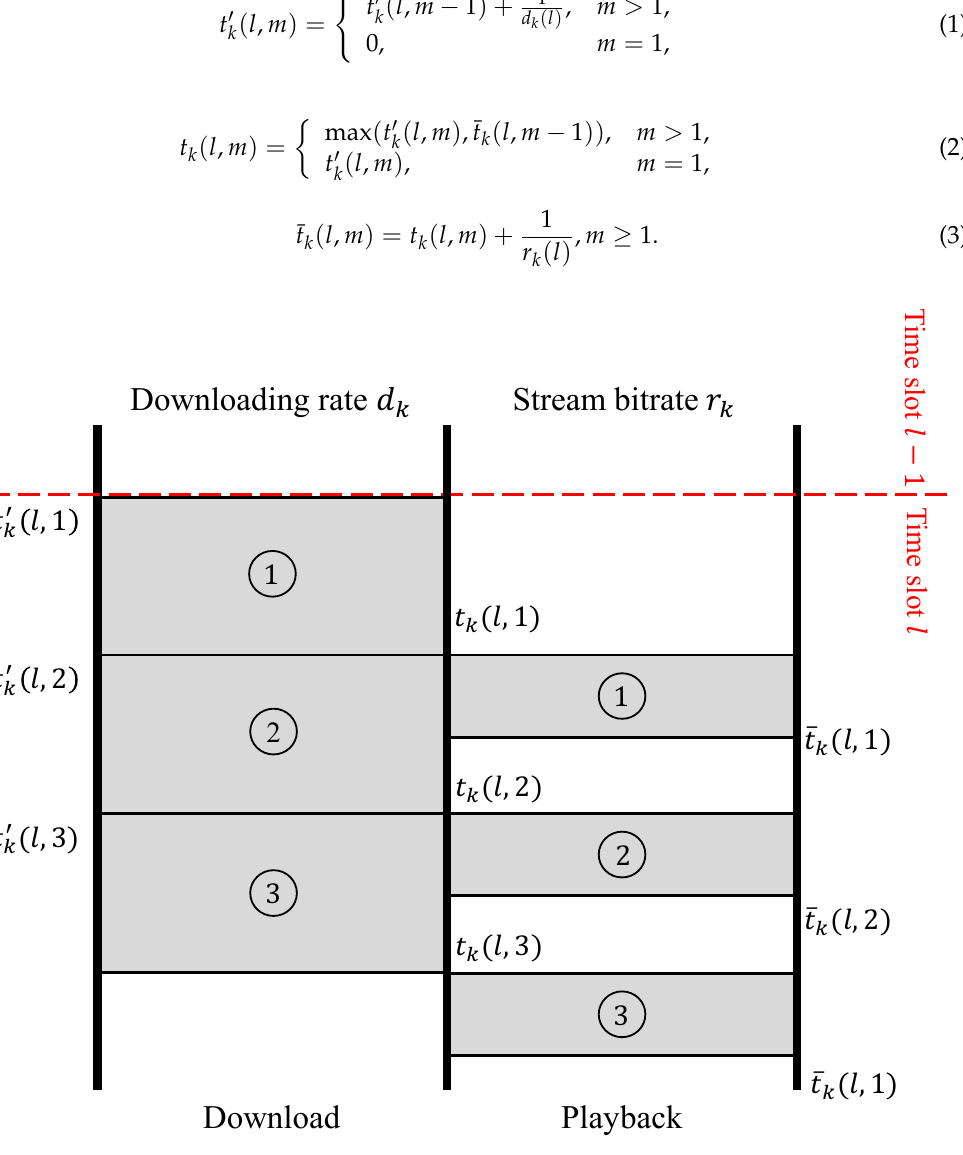
Figure 2. The stall time calculation for users request a new video triggering the system to move to slot l